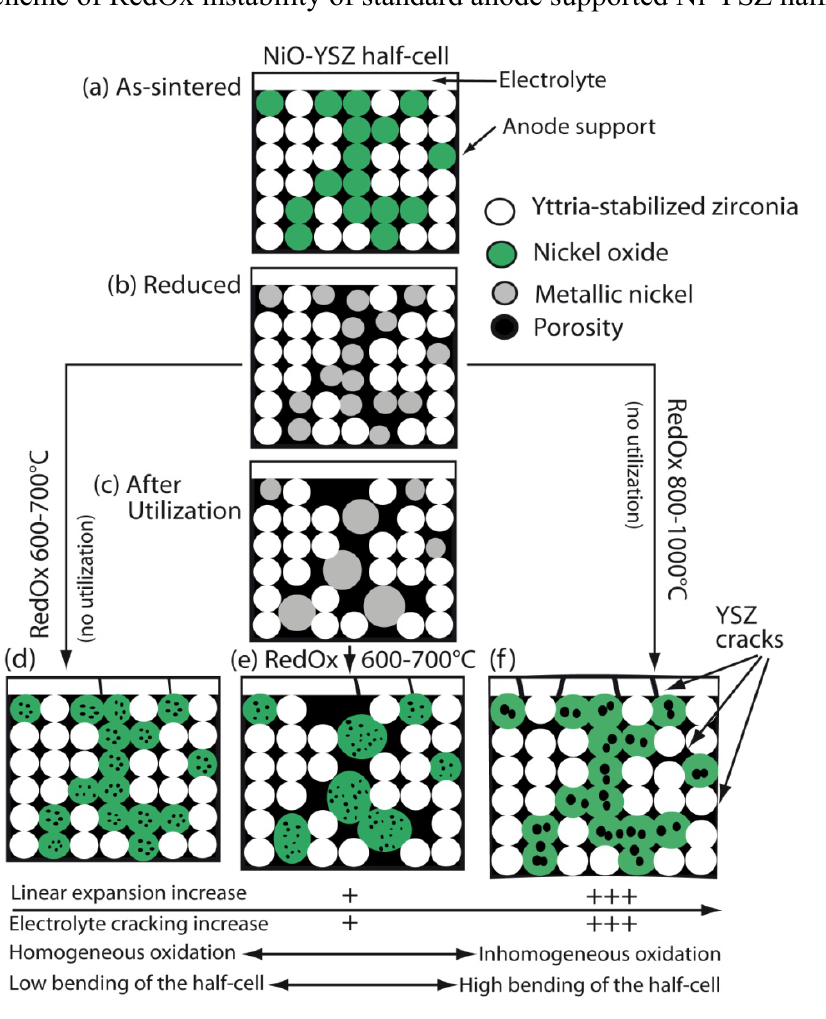
Figure 35. Scheme of RedOx instability of standard anode supported Ni-YSZ half-cell